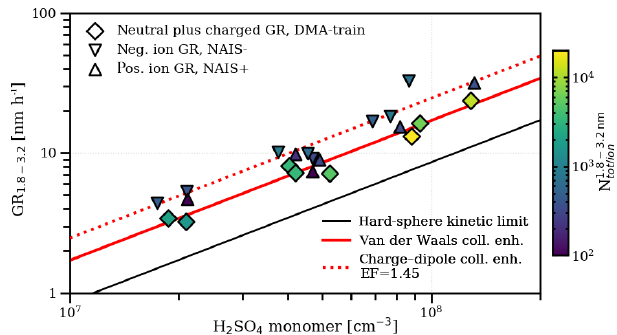
Figure 3. The effect of charge on growth. Measured growth rates of 1.8–3.2nm (mobility diameter) particles and ions in experiments with ammonia above 25pptv. The DMA-train measures both neutral and charged particles (diamonds), whereas the NAIS + / − (Man- ninen et al., 2009) measures purely charged particles (triangles). Both the positively and negatively charged particle population have a faster apparent growth rate than the total particle population due to an enhanced collision rate from charge–dipole interactions. We measure a multiplicative charge enhancement factor of 1.45 in this size range with a combined fit to both polarities (red dotted line), which is consistent with estimates from average dipole orientation theory (Nadykto and Yu, 2003). At galactic cosmic rays ionization levels in the chamber, the charged fraction of the growing particles in the size range from 1.8 to 3.2nm (mobility diameter) is between 5% and 25%. This is demonstrated by the colour code which in- dicates the integrated total or ion number concentration over the growth rate size interval averaged during the growth period. There- fore, the fit of the appearance time for the total particle population is affected on a minor level by the small, earlier appearing charged